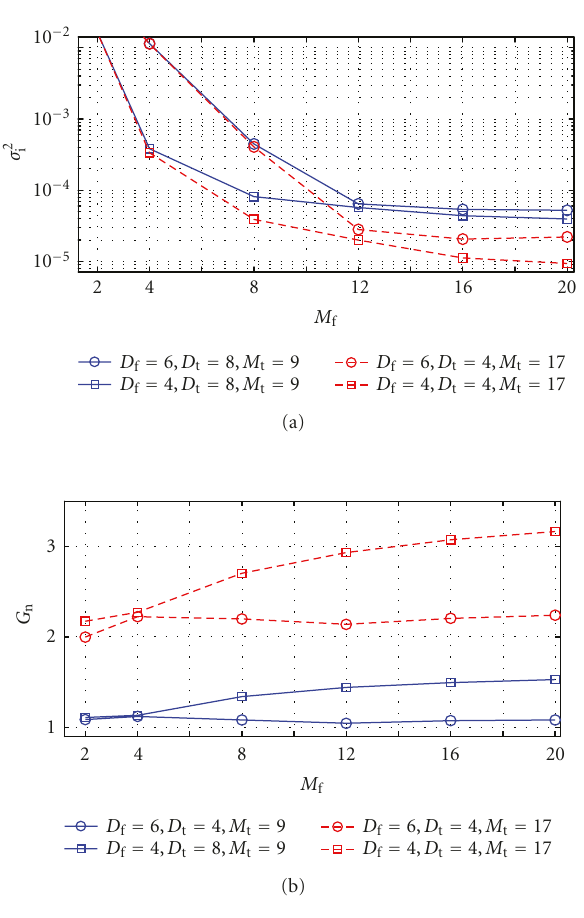
Figure 6: Interpolation error σ 2 = 30 dB against the filter order in frequency M of γ 0